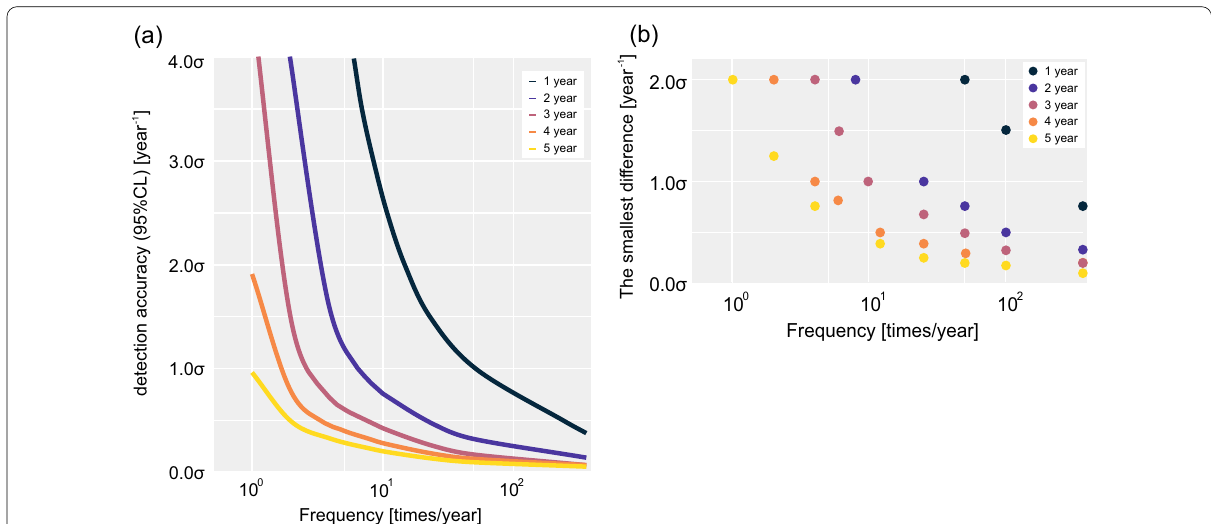
Fig. 2 a 95%CL of detected trend with respect to the observation frequency, with each color corresponding to an observation period between 1 and 5 year. b Smallest difference in the trends that can reject the null hypothesis that the trends are same, at a significance level of